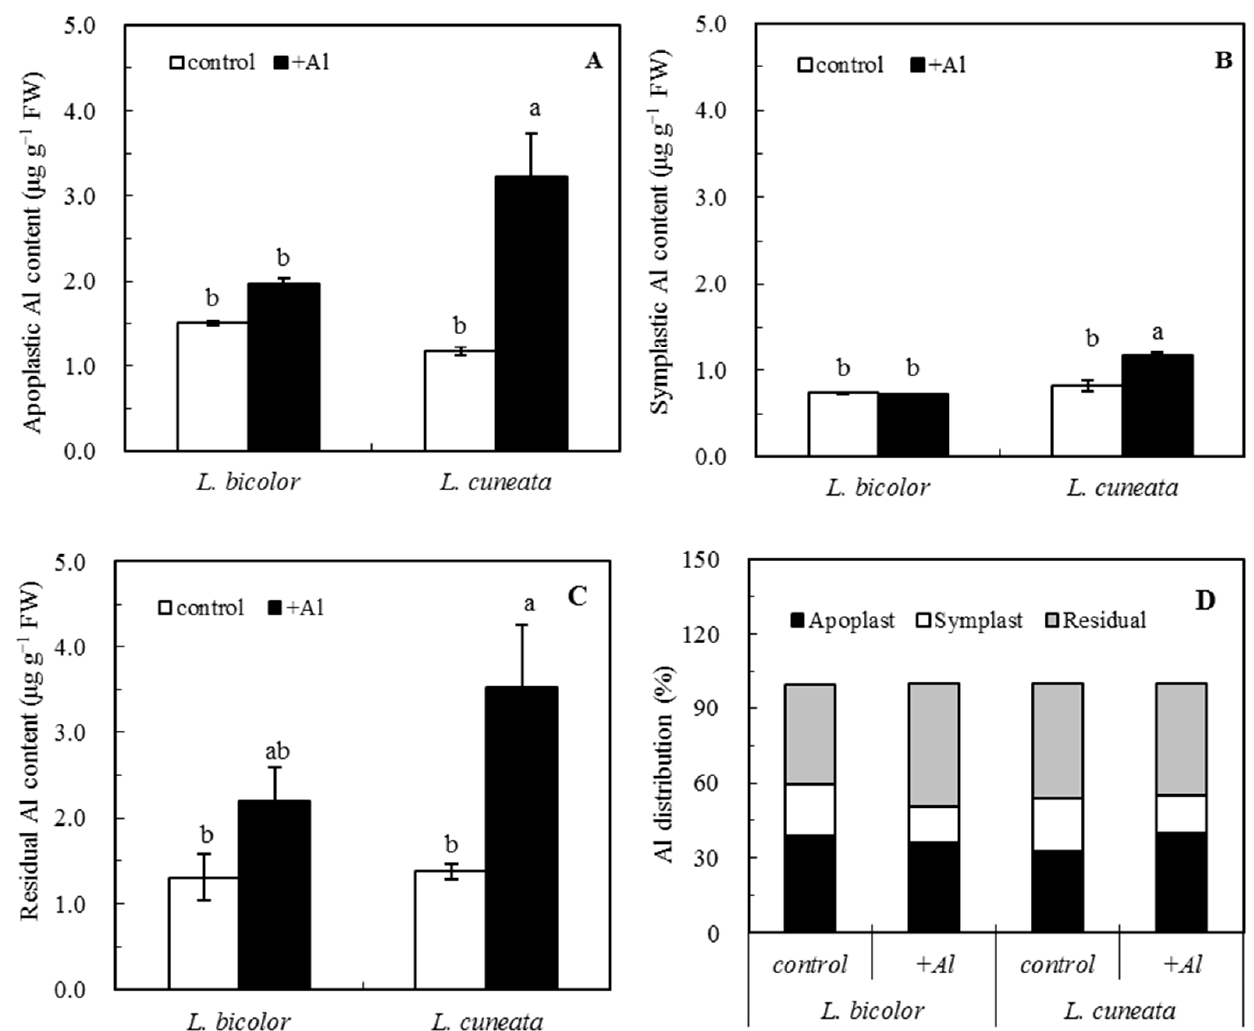
Figure 3. Distribution of Al in the root apices of two Lespedeza species. ( A ) apoplastic Al, ( B ) symplastic Al, ( C ) residual Al, and ( D ) percentage Al distribution in different fractions. Five-day- old seedlings were exposed to 0.5 mM CaCl 2 solutions (pH 4.5) containing 0 (control) or 50 µ M Al (+Al) for 24 h. The apoplastic, symplastic, and residual Al contents of root apices were analyzed. Significant differences between mean values are indicated by different letters at the p < 0.05 level (Tukey test). Error bars represent ± SD ( n = 3).